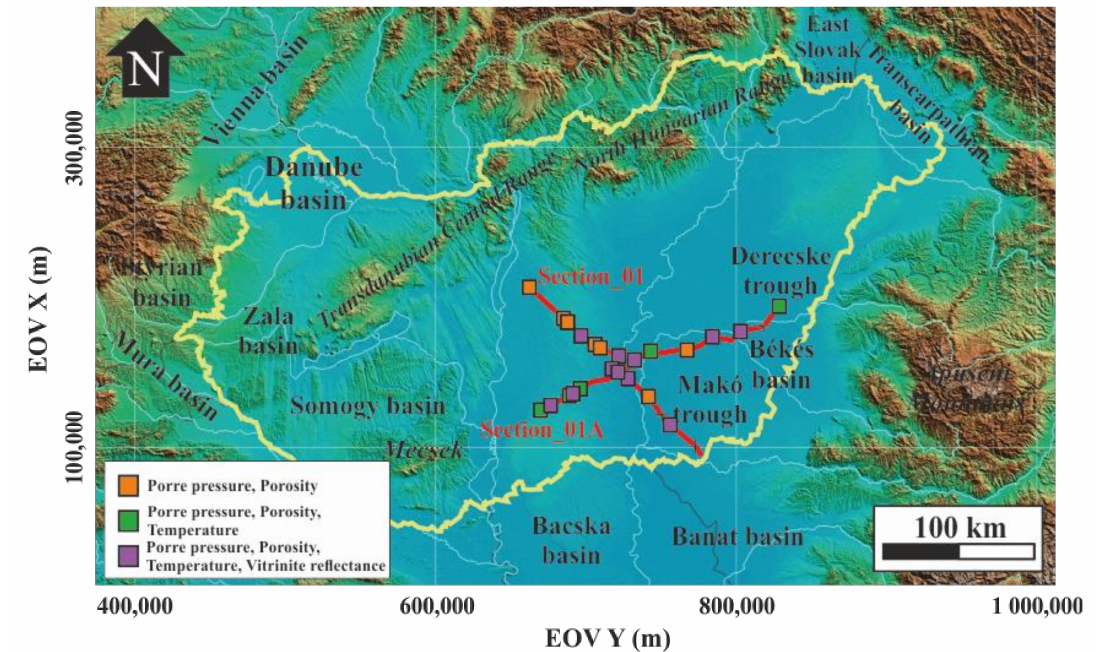
Figure 1. Topographic map of the Pannonian (modified after [13]) basin with the main subbasins; the yellow outline represents the political border of Hungary, and the red lines show the direction of the Section_01 (from NW to SE) and Section_01A (from NE to SW). The map uses EOV (Uniform National Projection system), which is a plane projection